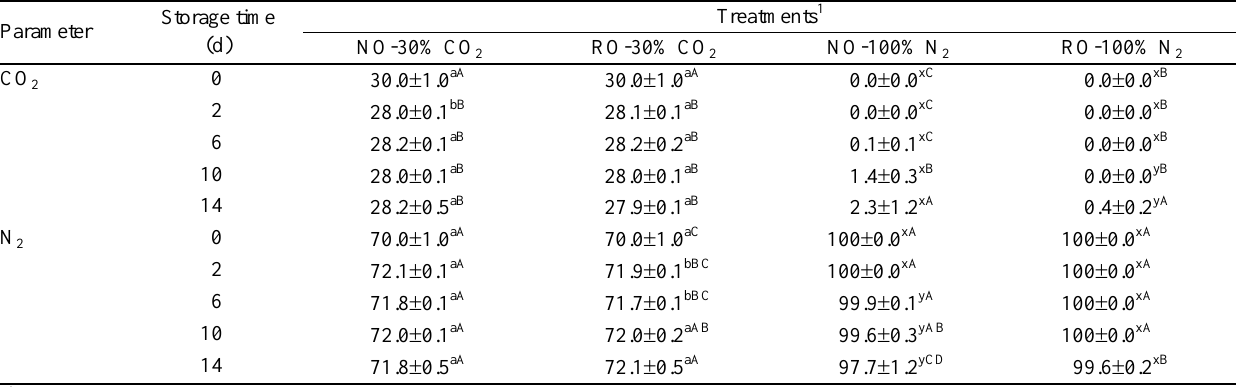
Table 1. The changes in headspace gas composition of modified atmosphere packaging (MAP) during refrigerated storage (%; mean  SE, n =